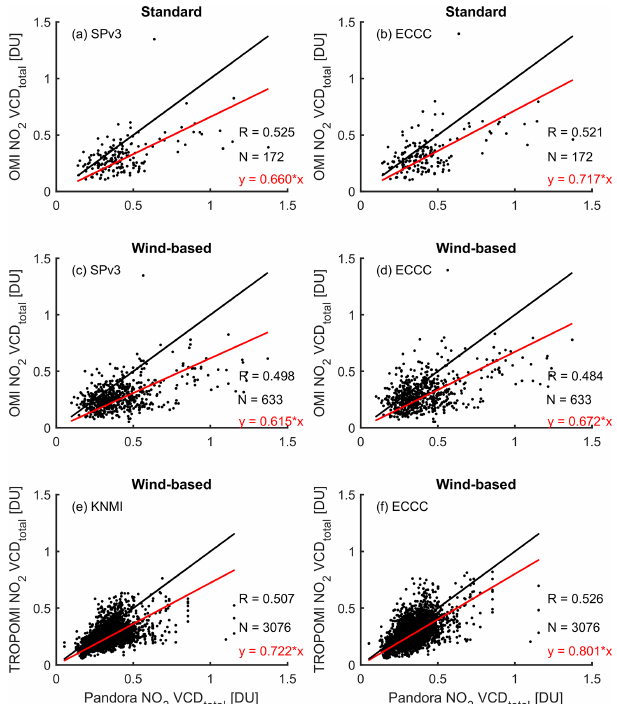
Figure 8. OMI and TROPOMI vs. Pandora no. 104 (Downsview) NO 2 total columns, using (a, b) the standard coincidence com- parison method for OMI SPv3 and OMI ECCC, respectively; (c, d) wind-based method for OMI SPv3 and OMI ECCC, respectively. (e) and (f) are results using the wind-based method for TROPOMI KNMI and ECCC, respectively, with an extended y rotate range. In each scatter plot, the red line is the linear fit with the intercept set to 0, and the black line is the one-to-one